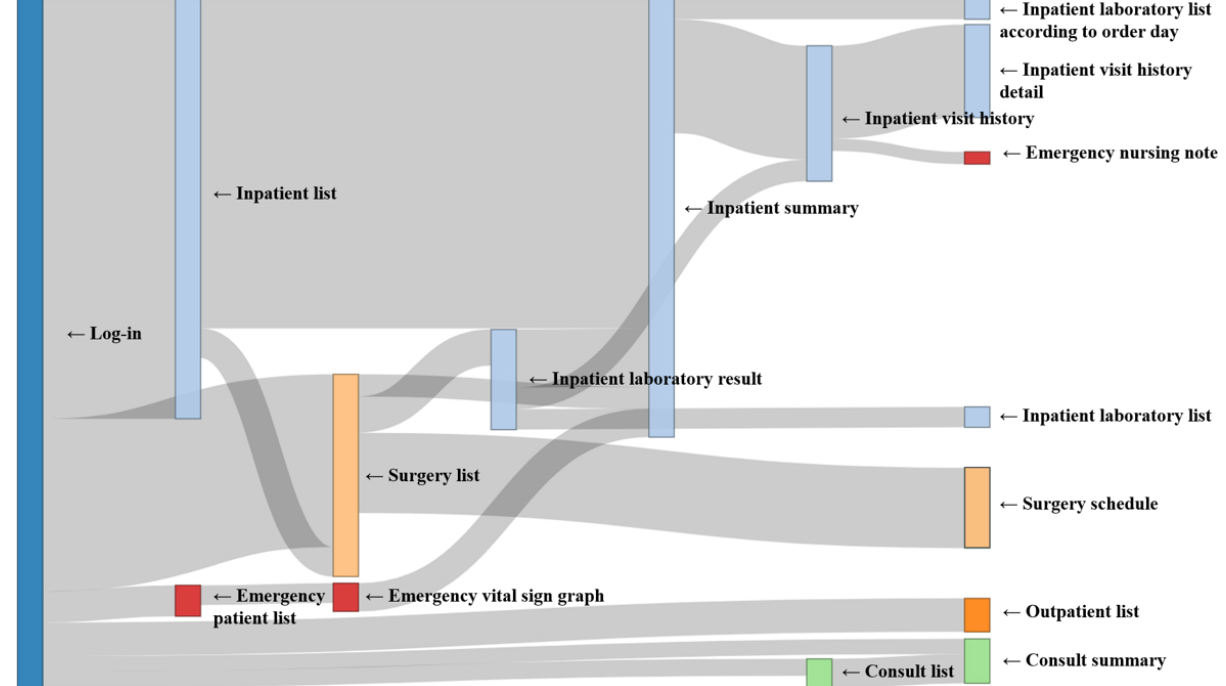
Figure 7. Sankey diagram of usage paths identified for the Surgeon group. Light blue, light green, light orange, orange and red colors were used to indicate impatient, consult, surgery, outpatient and emergency features,